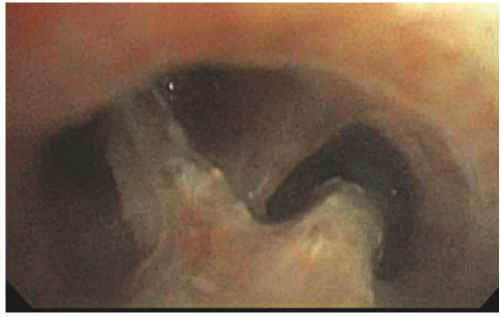
Figure 3: Bronchoscopic image at the level of the main carina with “tissue-like” material evident.